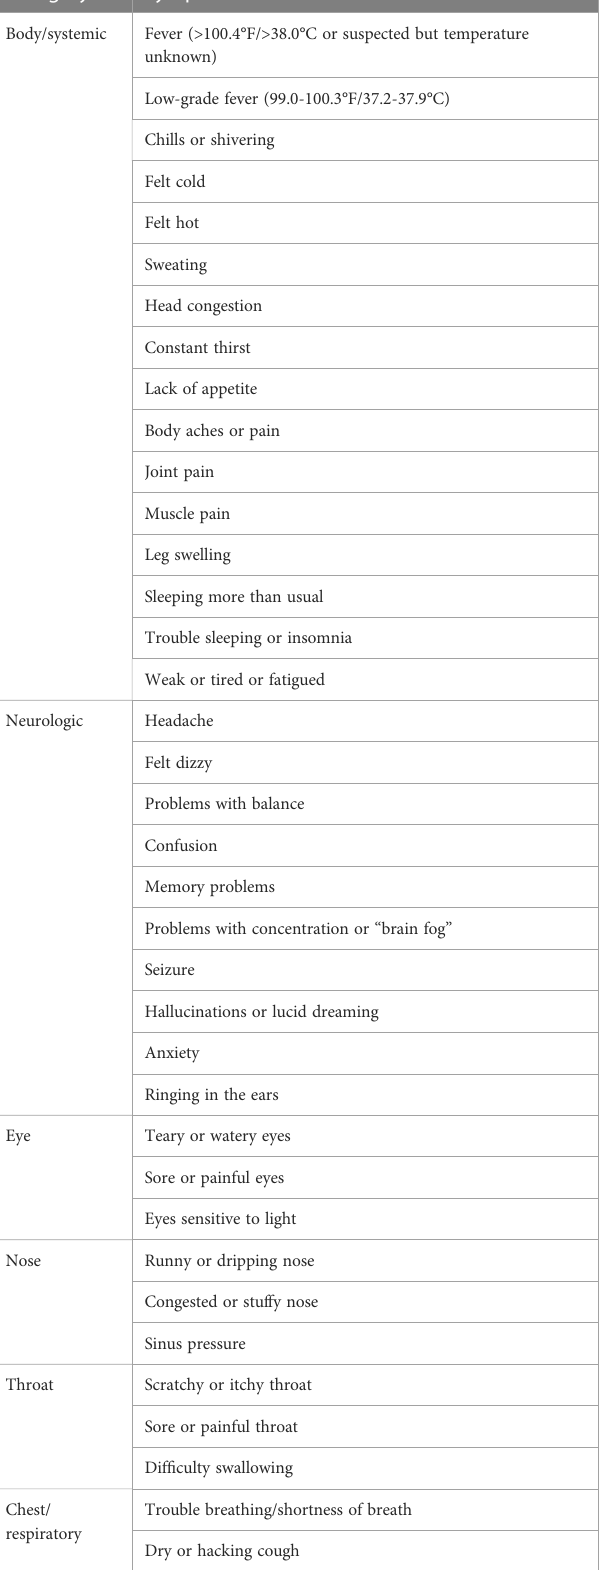
TABLE 1 List of the 49 long COVID symptoms assessed in surveys at 1, 3, 6, 12, and 18 months from enrollment.